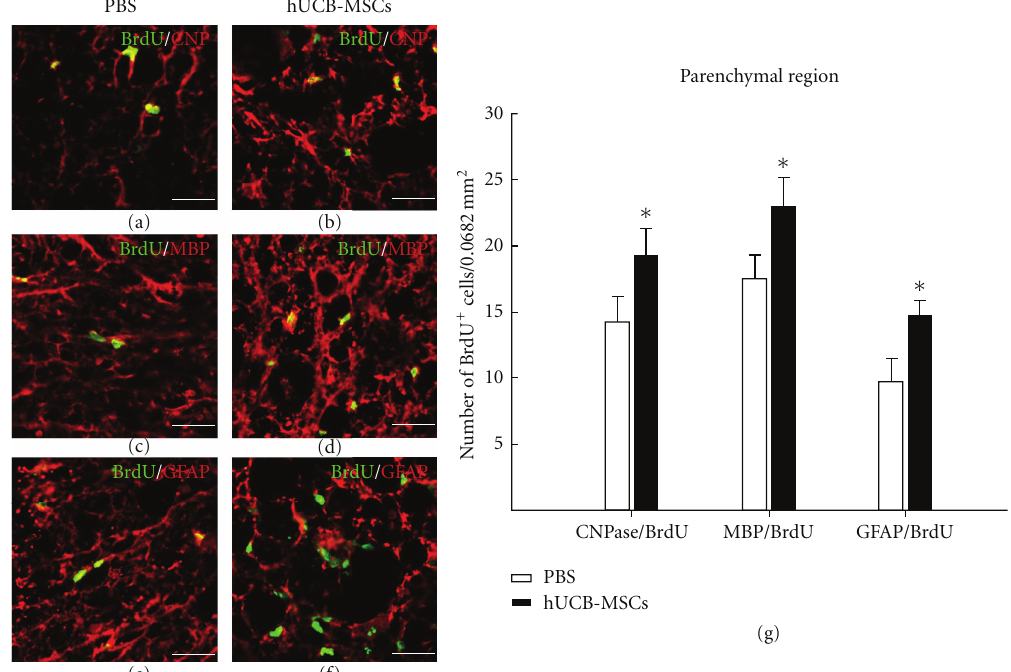
Figure 4: Quantitative analysis of endogenous oligogenesis by hUCB-MSCs. At 2 weeks after cell transplantation, BrdU and cell-specific markers were observed up to the edge of the SCI region. (a) and (b) BrdU/CNPase-labeled cells were present. (c) and (d) BrdU/MBP-labeled cells. (e) and (f) BrdU/GFAP-labeled cells. (g) Quantity of BrdU/CNPase, MBP, and GFAP-labeled cells. ∗ P < 0 . 05. Scale bars: 10 µ